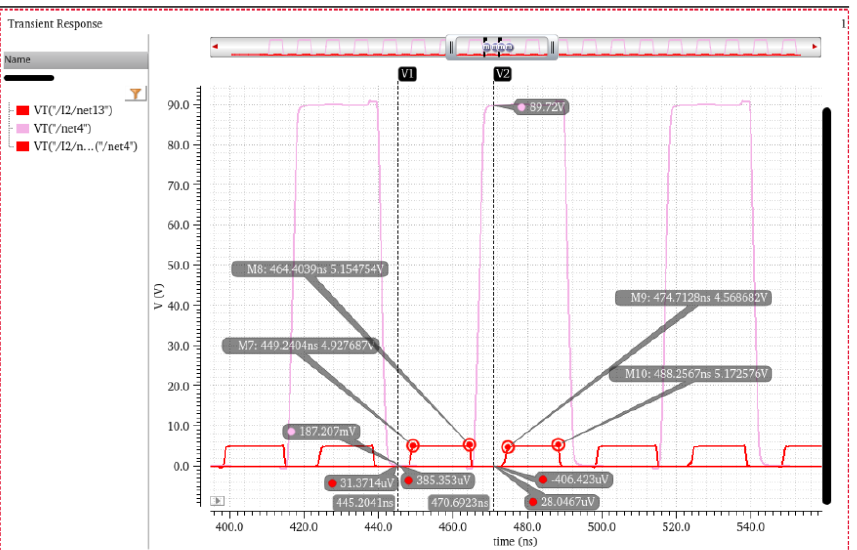
Figure 12. Overall simulation.